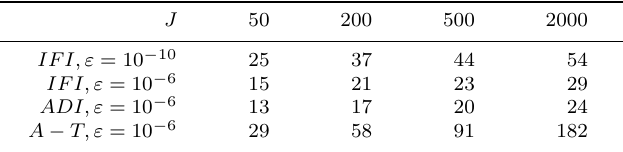
Table 3. Number of iterations on J . Dirichlet problem, the 9-point solver, 9-point scheme.